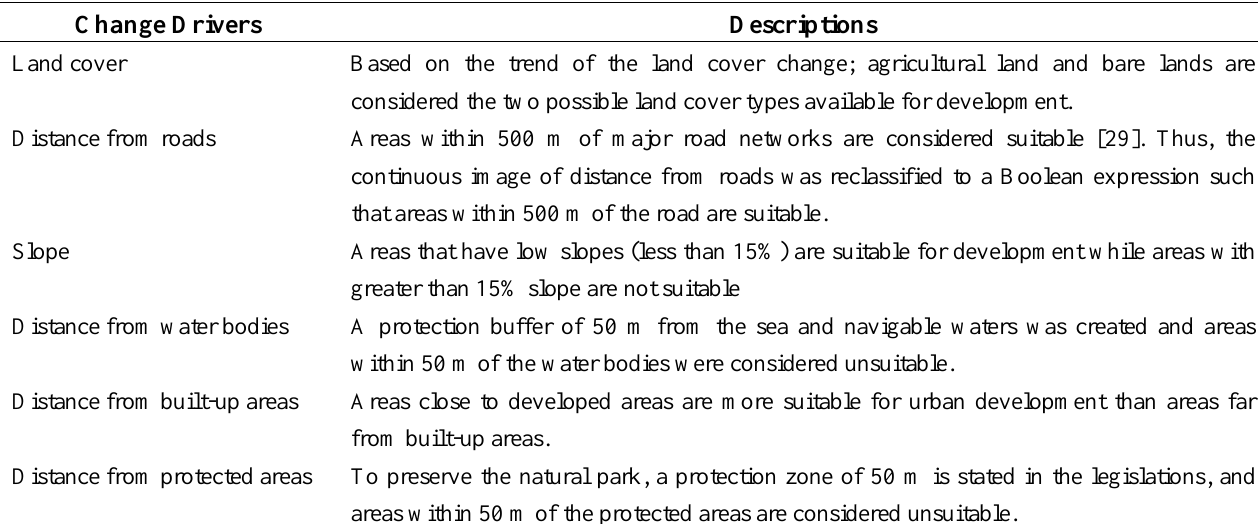
Table 3. Boolean approach criteria